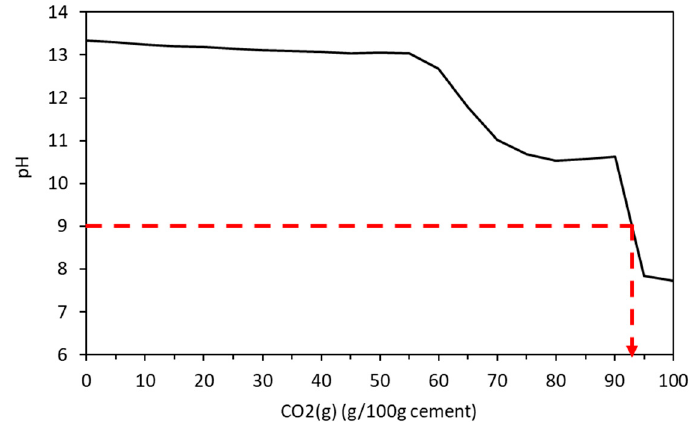
Figure 14. Change in pH due to ongoing carbonation.